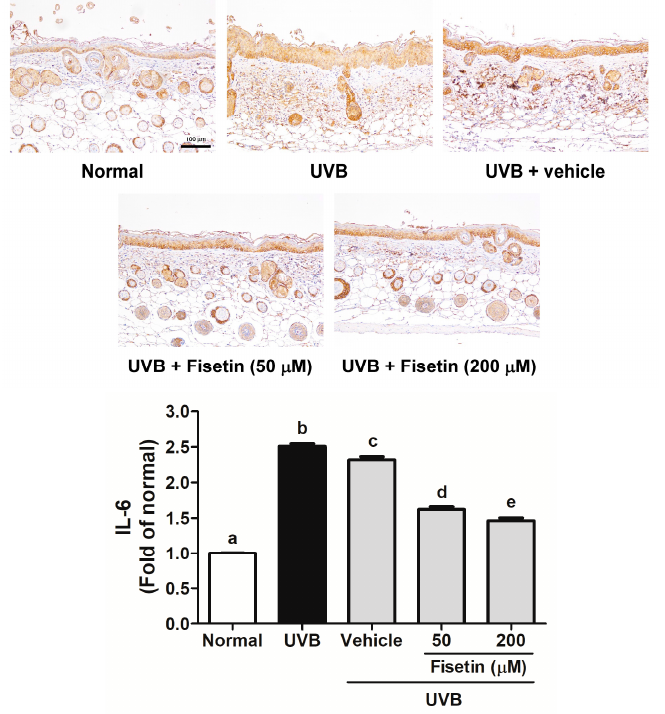
Figure 9. Immunohistochemical staining of COX-2 expression in the epidermis of the mouse skin slices. Fisetin inhibits UVB-induced COX-2 overexpression (200×). a–d: Values not followed by a common letter are significantly different ( p < 0.05).